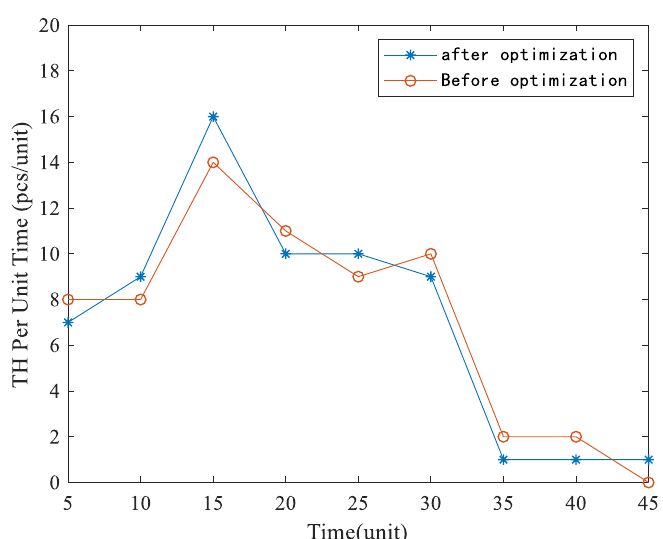
Figure 10. Comparison of experimental results before and after input parameter optimisation.